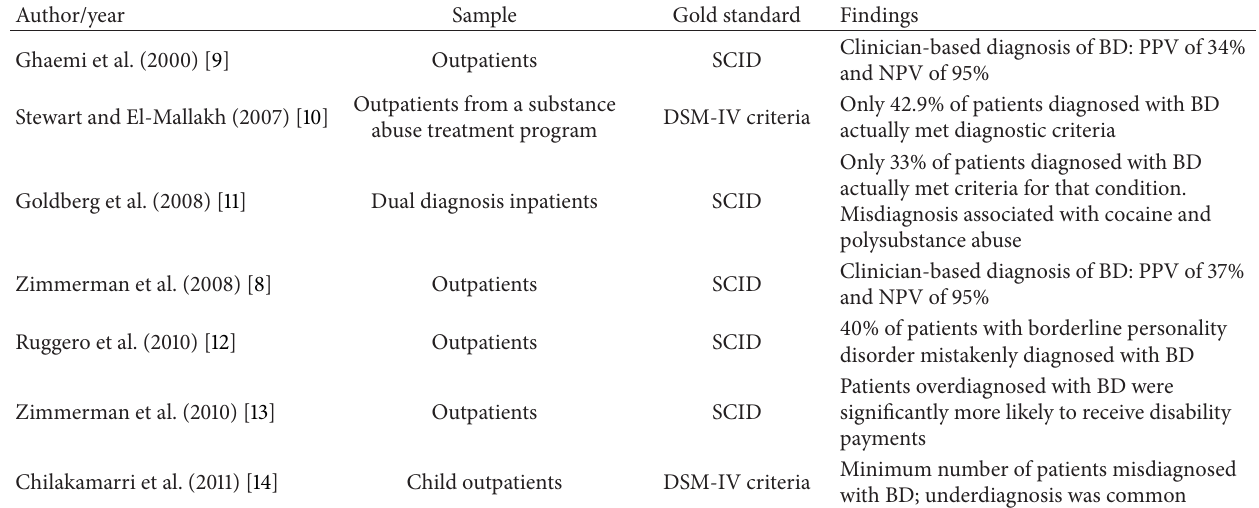
Table 1: Studies addressing the overdiagnosis of bipolar